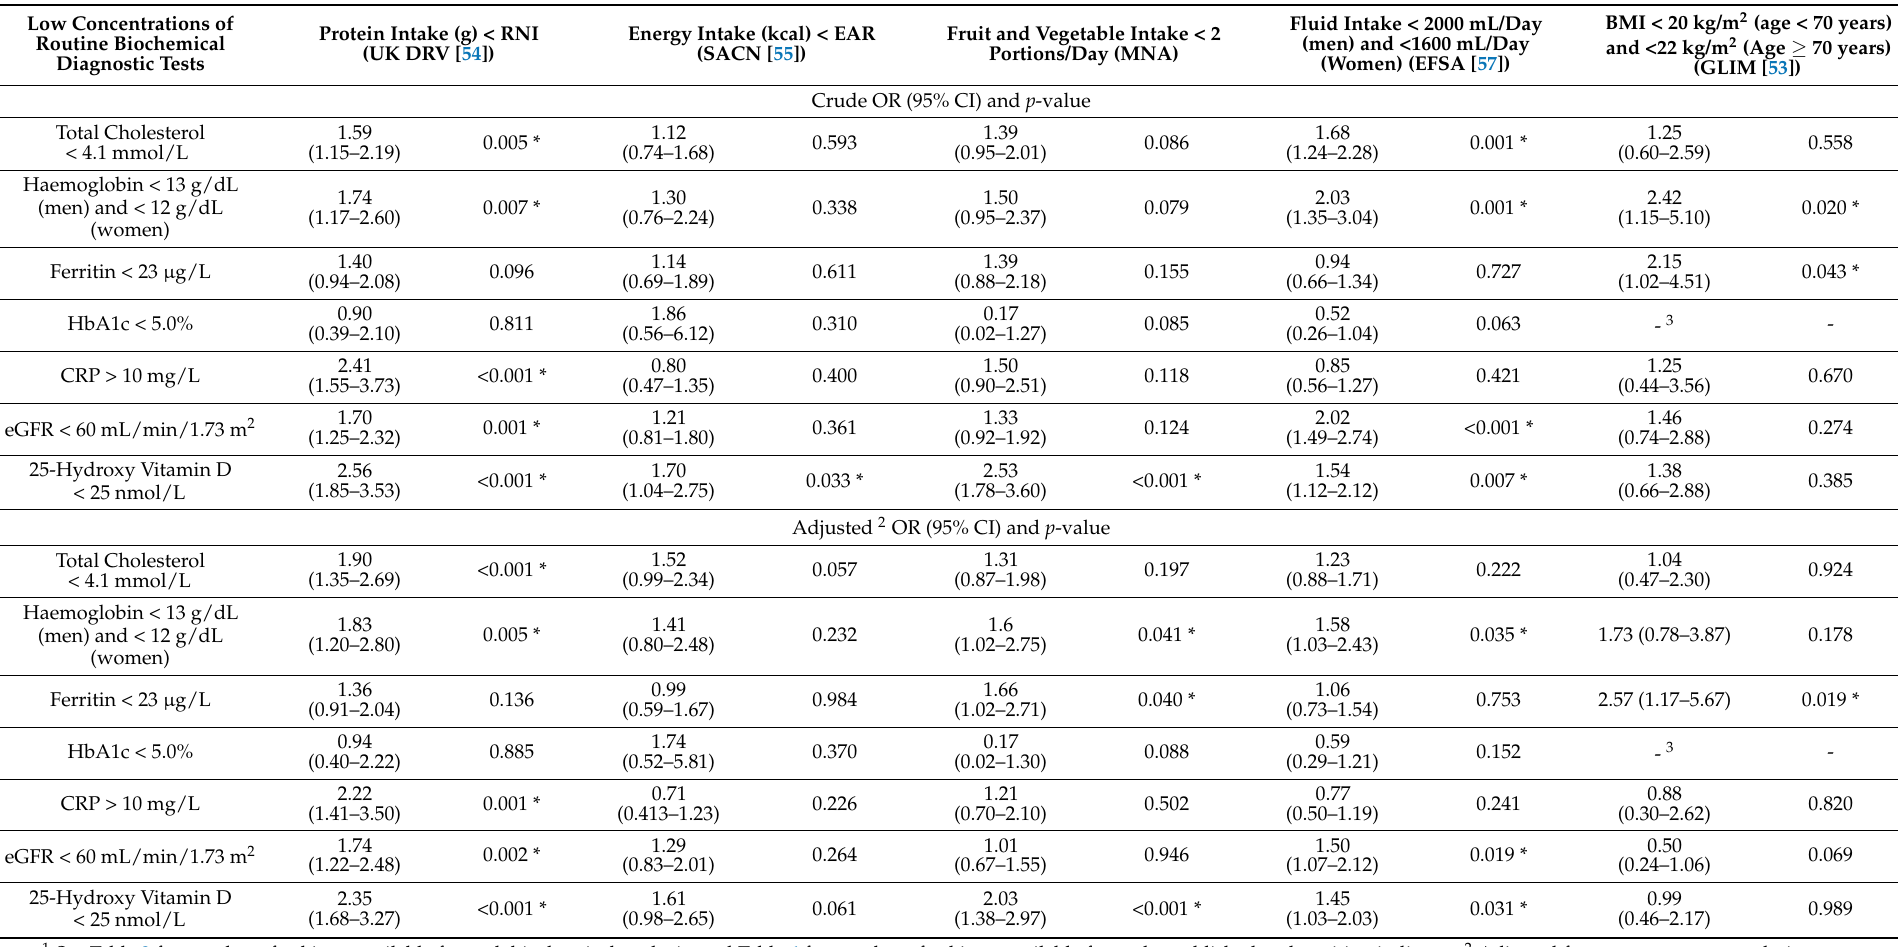
Table 5. Multiple univariate logistic regression analyses of the established malnutrition indicators as dependent binary variables and each routine biochemical diagnostic test individually as independent binary variable, unadjusted and adjusted 1 (Stage